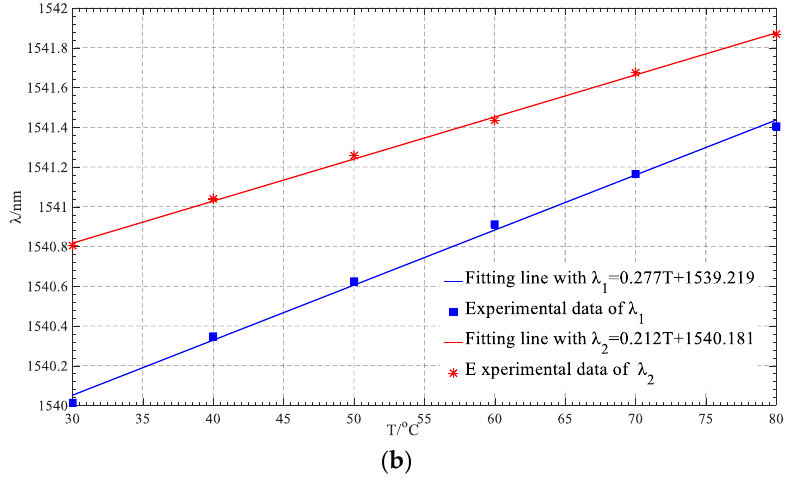
Figure 5. Temperature sensing of Type B ( a ) spectra at 30 to 80 °C ( b ) temperature sensitivity.